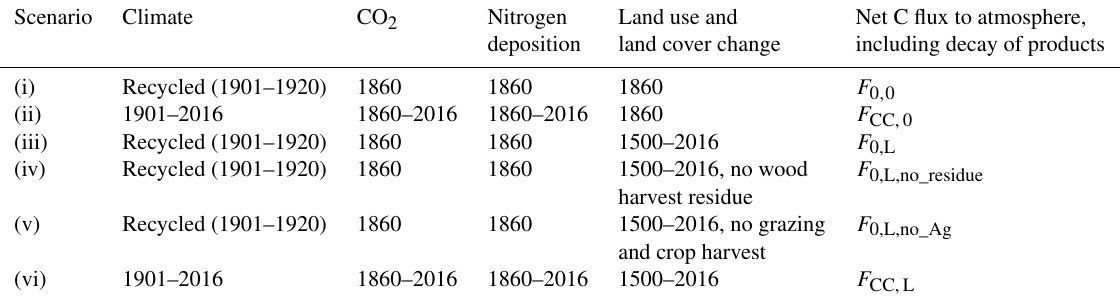
Table 2. Simulation